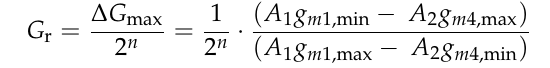
Figure 4. ( a ) Conventional methods t o obtain Δ G max and G r ; ( b ) a new method to configure Δ G max and G r with proposed asymmetric capacitor-based reconfigurable technique; ( c ) with different val- ues of C x , simulated small-signal gain versus frequency at the maximum and minimum control states.